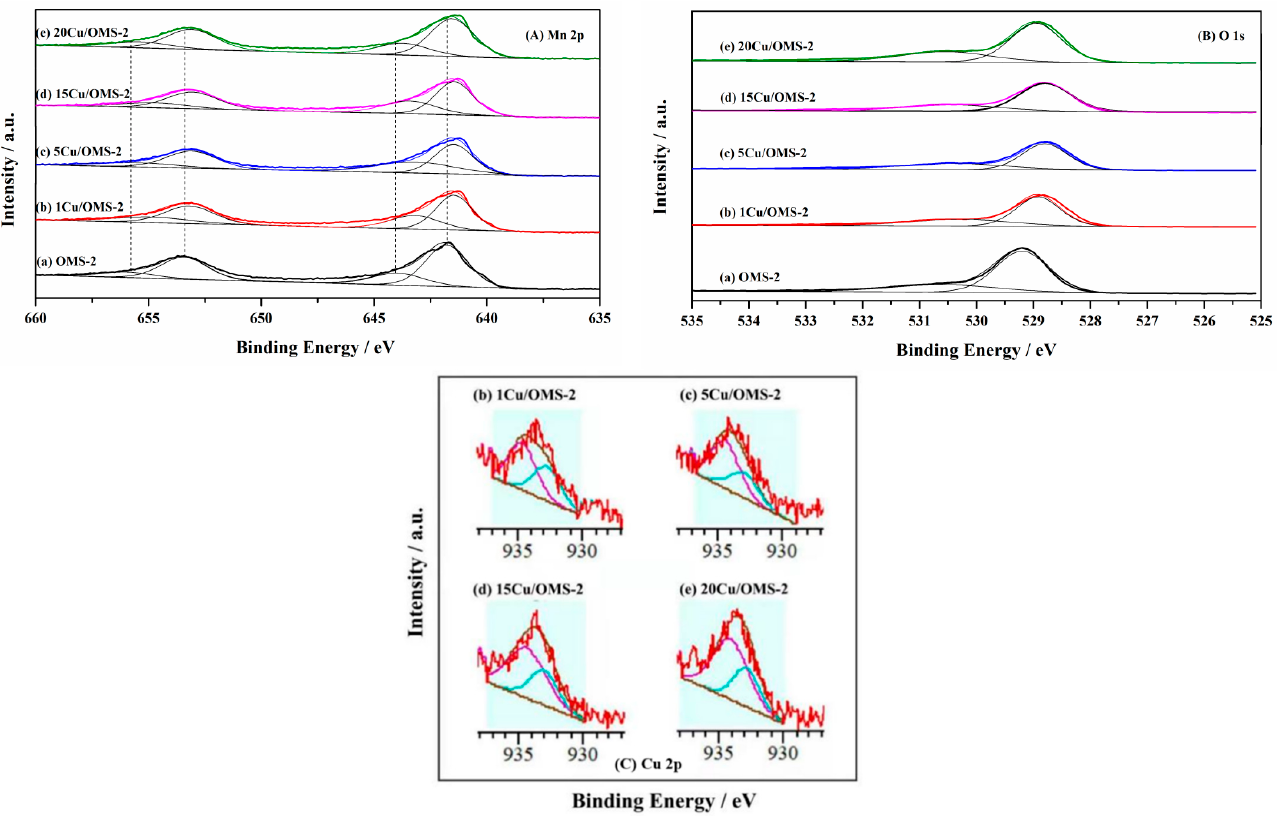
Figure 5. ( A ) Mn 2p, ( B ) O 1s, and ( C ) Cu 2p XPS spectra of ( a ) OMS-2, ( b ) 1Cu/OMS-2, ( c ) 5Cu/OMS-2, ( d ) 15Cu/OMS-2, 5Cu/OMS-2, ( d ) 15Cu/OMS-2, and ( e ) 20Cu/OMS-2. and ( e )